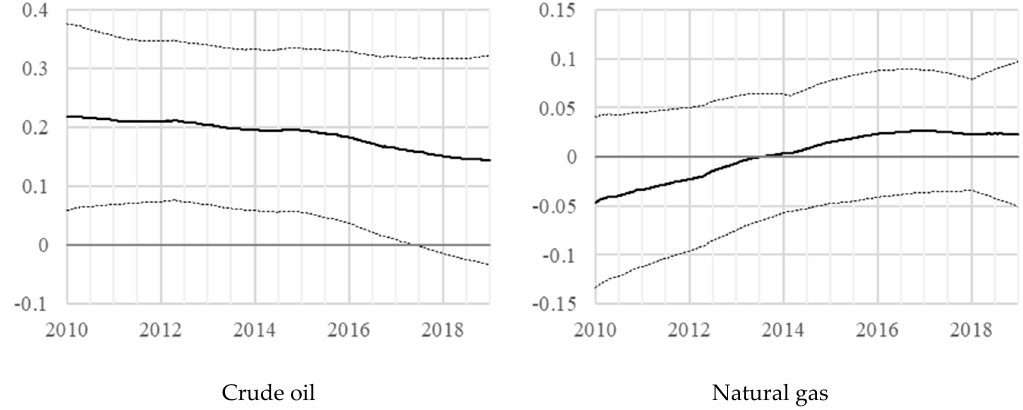
Crude oil Natural gas Figure 3. Time-varying coe ffi cients of ethylene price on crude oil price ( left ) and natural gas price ( right ) in a cointegration equation.